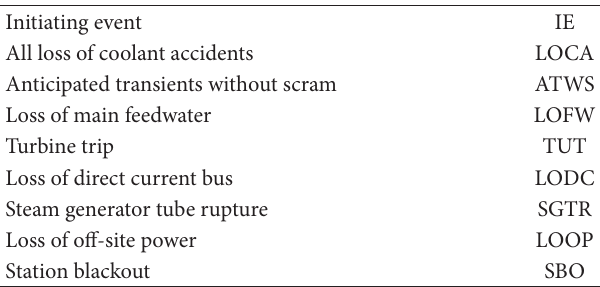
Table 2: Initiating events.